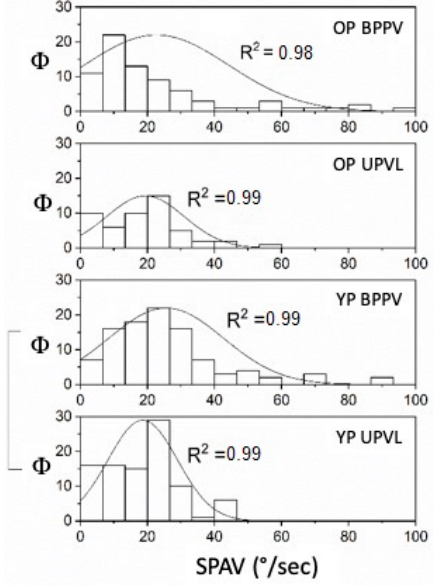
Figure 6. SPAV ( ◦ /s) of SVINT comparisons between UPVL and BPPV in older and younger patients Figure 6. SPAV (°/s) of SVINT comparisons between UPVL and BPPV in older and ( Φ = data distribution frequency). The Gaussian peak represents the mean of SPAV in Hz. Frequency younger patients ( Φ = data distribution frequency). The Gaussian peak represents the distribution and fitting analysis in fit R 2 = 0.99 for all curves except OP BPPV, that is R 2 = 0.98. mean of SPAV in Hz. Frequency distribution and fitting analysis in fit R 2 = 0.99 for all ( p = curves except OP BPPV, that is R 2 = 0.98. ( p = 0.001).